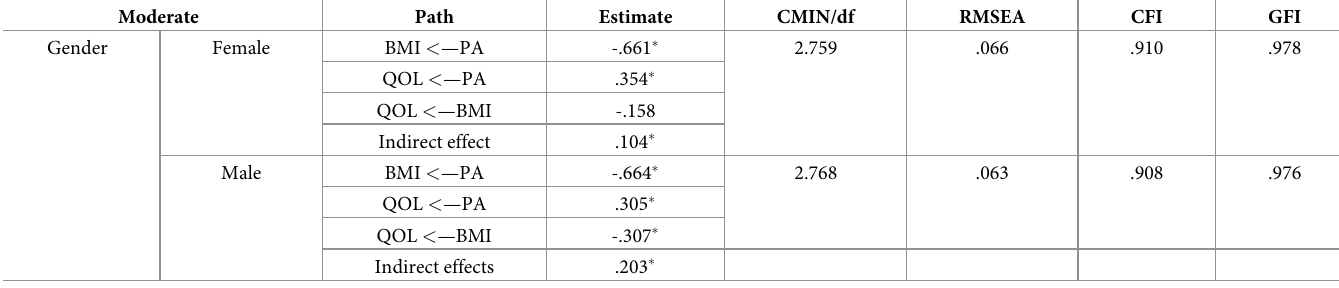
Table 5. The effect of gender as a moderator and body mass index as a mediator for physical activity and quality of life among students. Moderate